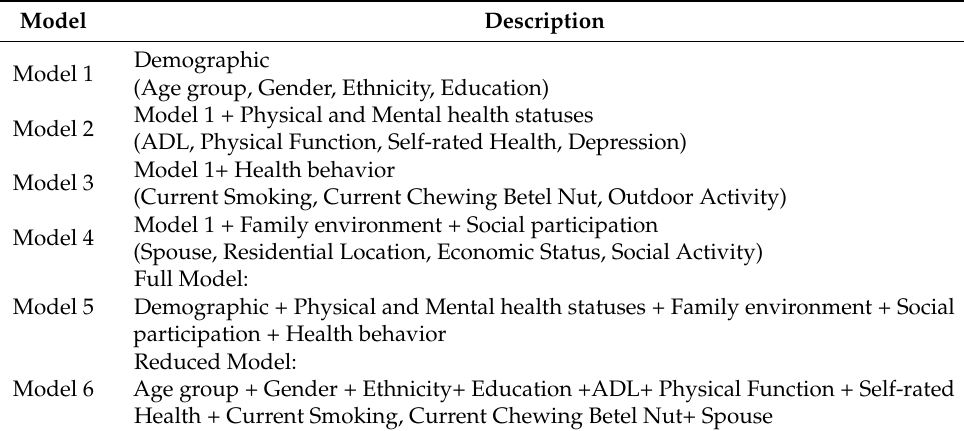
Table 2. The descriptions of Model 1 to Model 6.